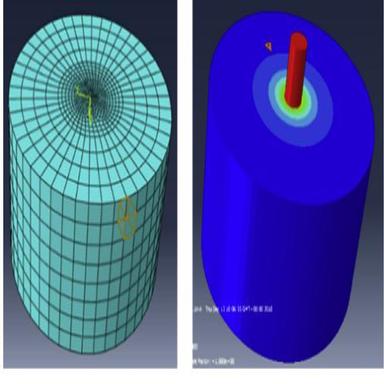
3D FE model of Indentation testing.